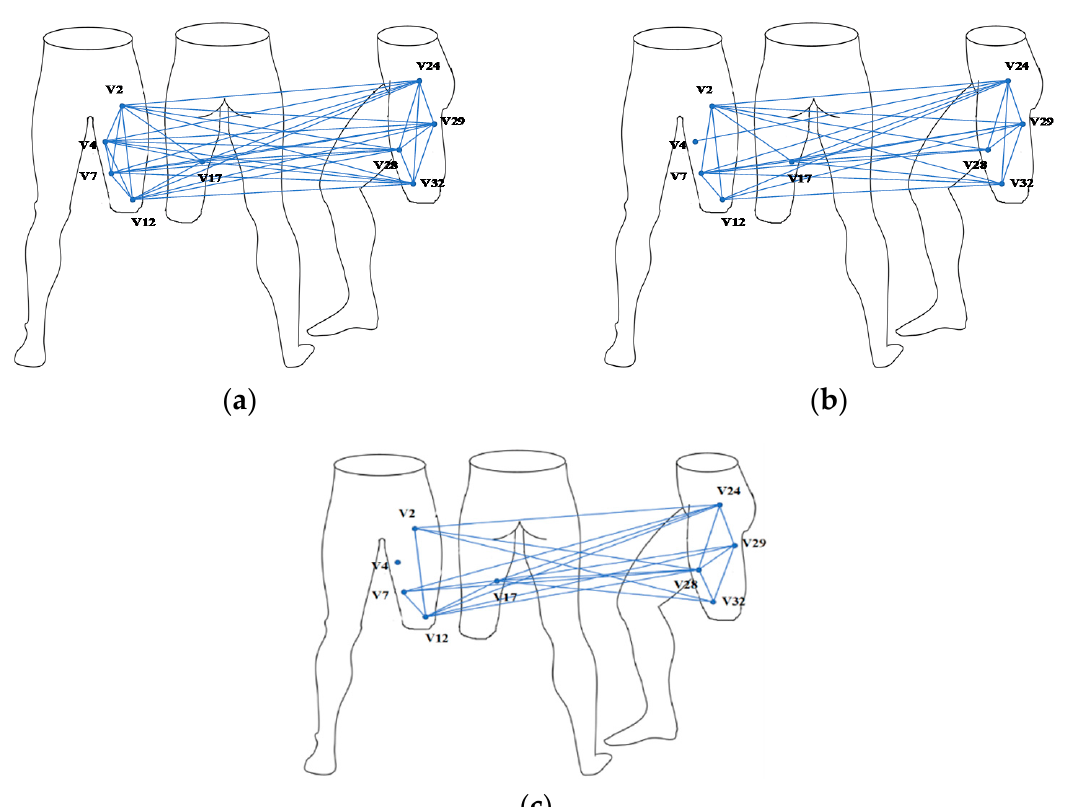
Figure 12. Muscle functional network of selected nodes: ( a ) appropriate angle, ( b ) excessive angle, ( c ) angle too small.